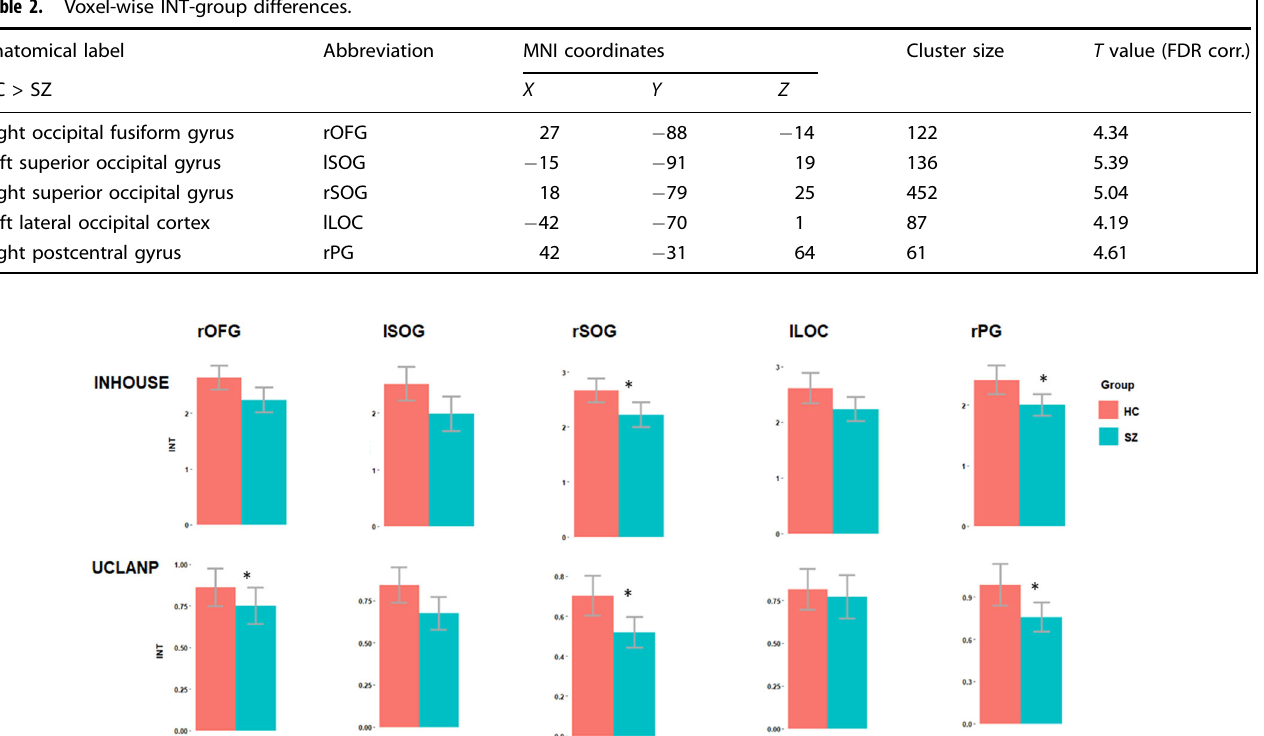
Fig. 2 Group differences in intrinsic neural timescales (INT) per sample and cluster, prior to FD outlier elimination. Bonferroni-corrected signi fi cant differences are marked. Red colour represents HC, while blue represents SZ. The asterisk indicates a P < 0.05 signi fi cance